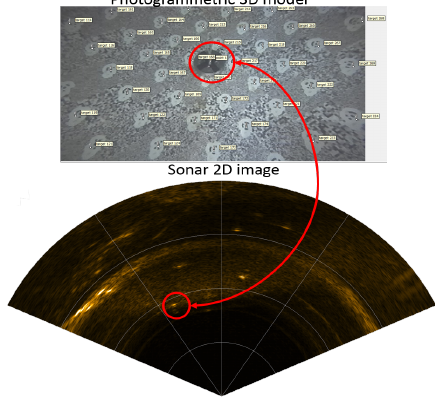
Figure 9. Target identification and correspondence between ZED2 and sonar